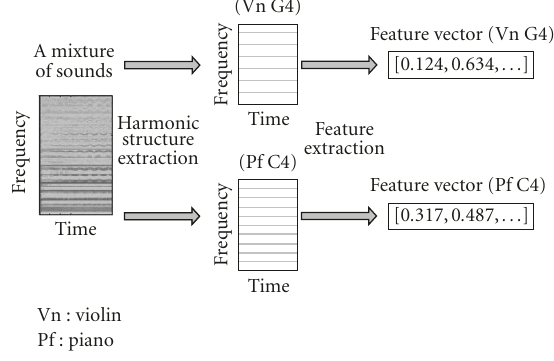
Figure 1: Overview of process of constructing mixed-sound tem- plate.